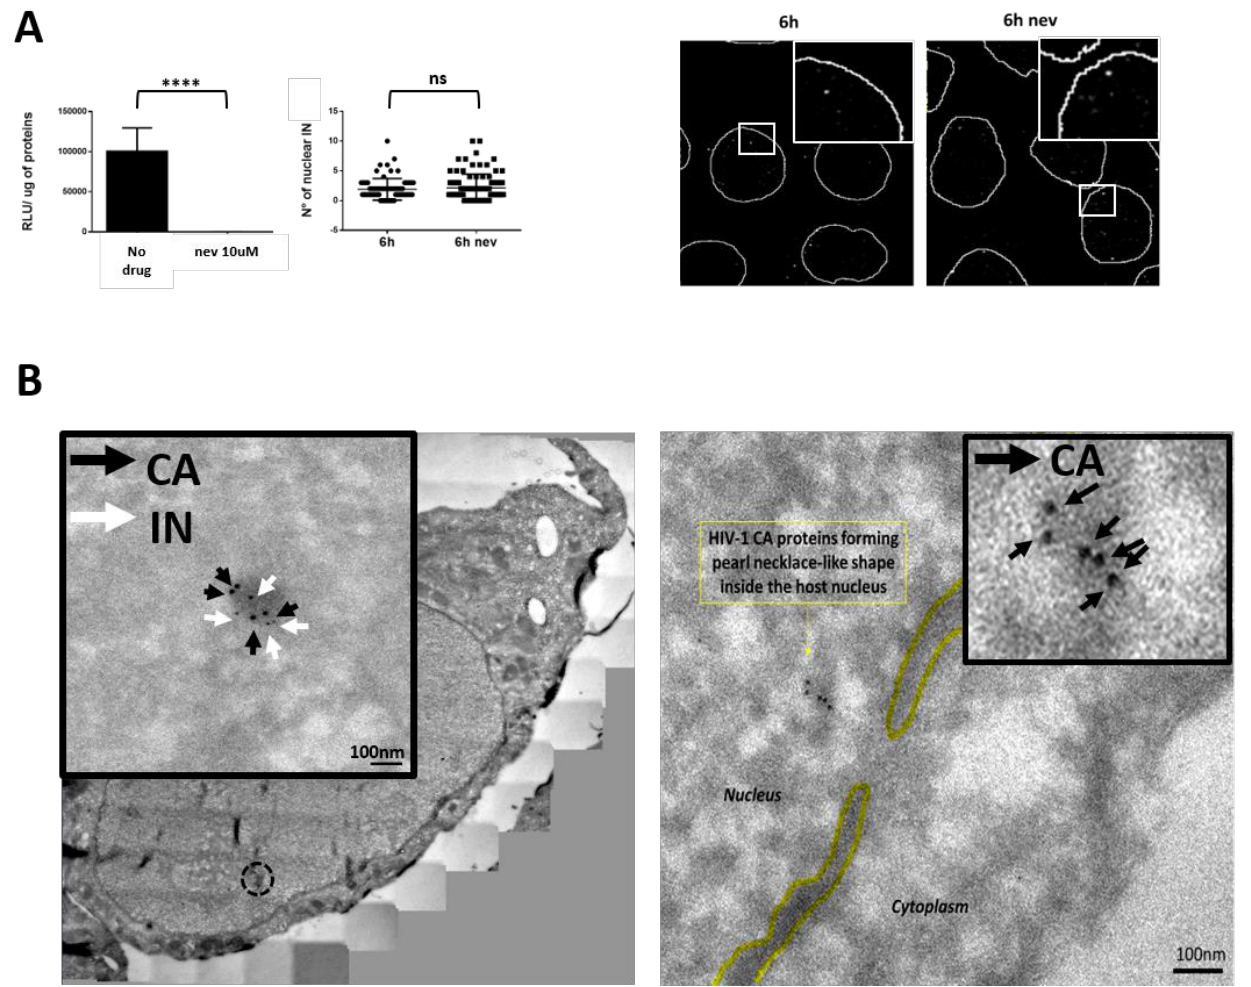
Figure 2. The inhibition of HIV-1 retrotranscription by nevirapine does not block nuclear import of HIV. ( A ) The use of nevirapine (10 µ M) efficiently inhibits the reverse transcription and therefore the replication of HIV-1. This blockage does not impede the import of HIV-1 integrase to the nucleus at 6 h post-infection, as the fluorescence microscopy image shows (antibody against the IN-HA tagged has been employed with a secondary antibody conjugated with Alexa 647). ( B ) Transmission electron microscopy (TEM) coupled to immuno-gold labeling (antibodies anti CA and anti IN-HA, respectively recognized by secondary antibodies conjugated with gold particles of 10 nm and 5 nm) reveals the presence of HIV-1 integrase and capsid complexes in the nucleus of infected cells in the presence or in absence of nevirapine. Black arrows represent capsid, whereas integrase is pointed out by the white arrows. p -values with <0.0001 are represented by **** than Images adapted from https://www.pasteur.fr/fr/journal-recherche/actualites/technologie-hiv-1-anchor-devoile-vih- 1-cellules-vivantes-lors-etape-entree-nucleaire, accessed on 2 June 2021and results corroborating the Blanco-Rodriguez et al. study